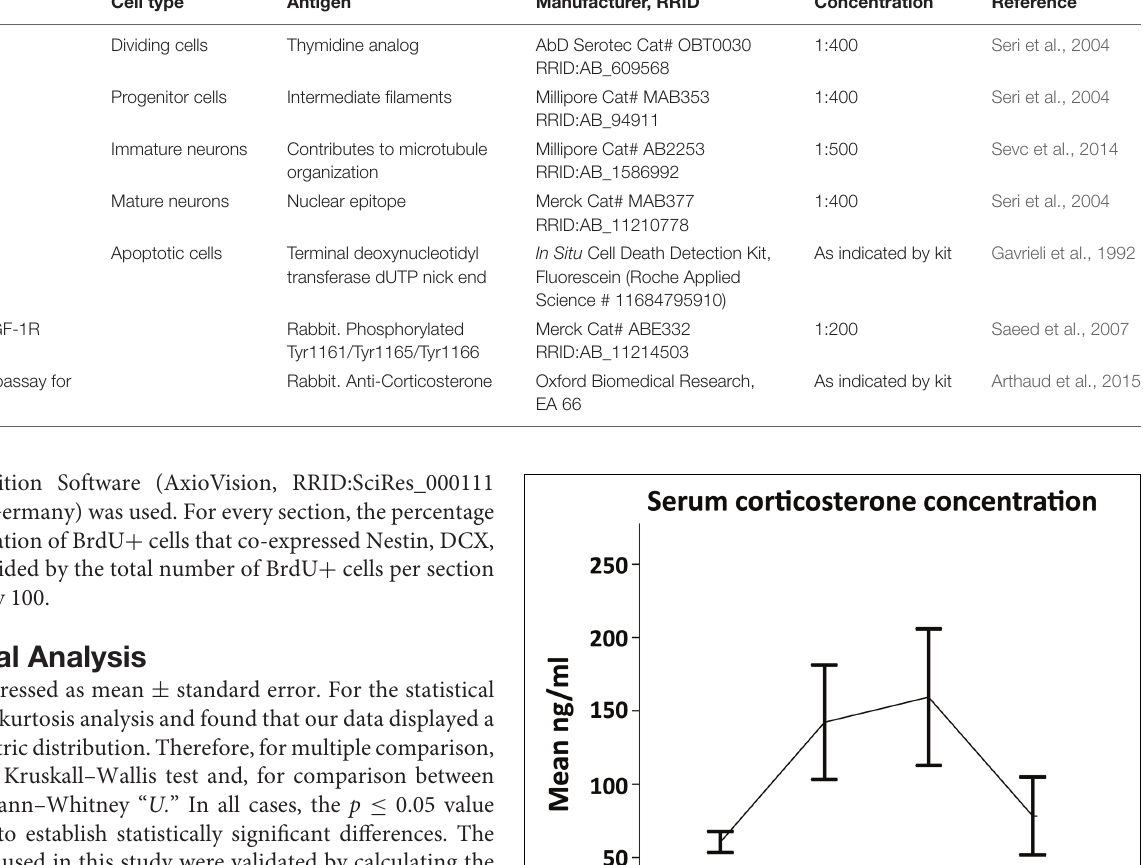
TABLE 1 | Antibody characterization for immunohistochemistry, ELISA and Western Blot. Marker